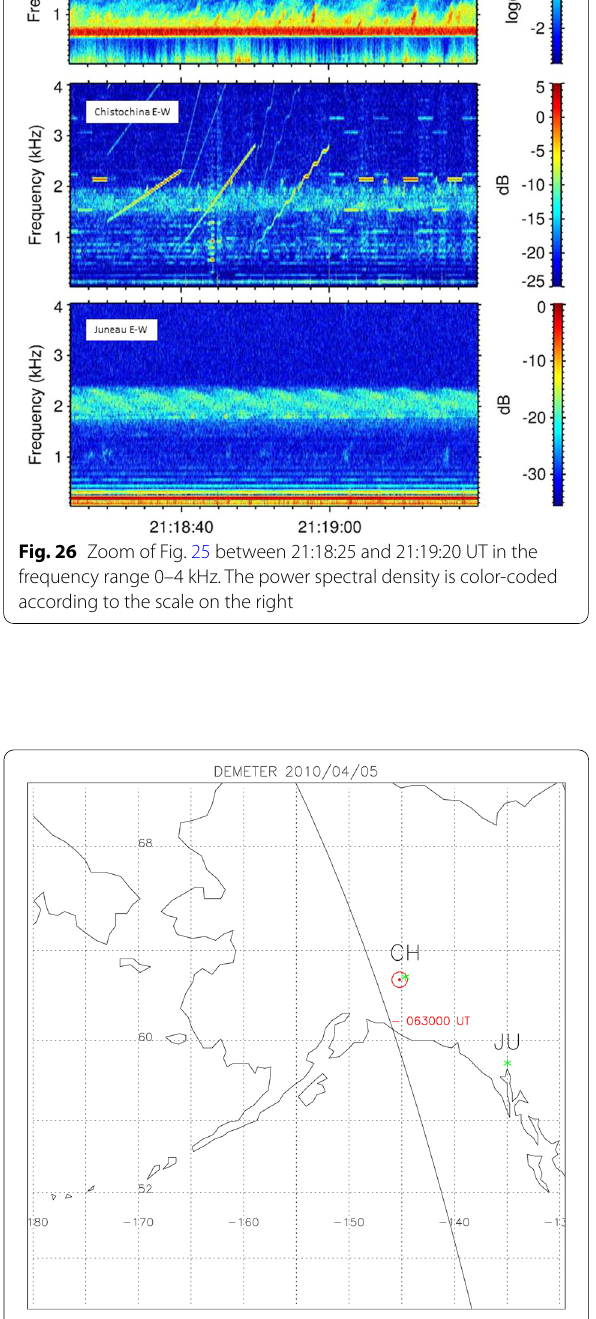
Fig. 27 Map showing the orbit of DEMETER on April 5, 2010 and the HAARP location (red symbol). The positions of Chistochina and Juneau are also